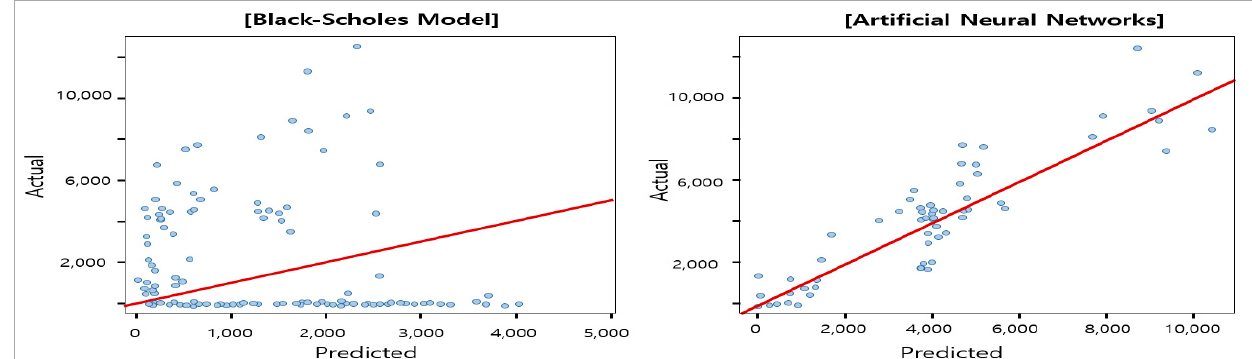
Figure 7. Selection of optimal parameters of random forest.